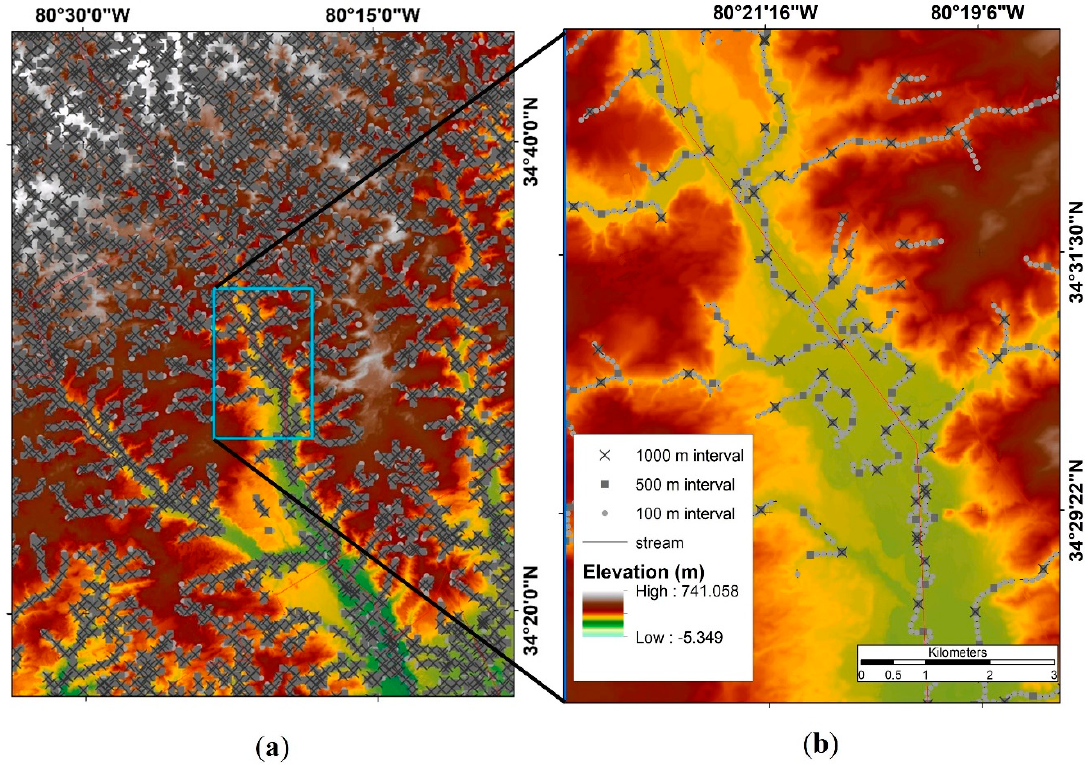
Figure 3. Process of gathering sampling points used as data input for interpolation: ( a ) shows an overview of the points gathered within the stream across the landscape and ( b ) shows the different interval of sampling points which affects the accuracy of the interpolation.